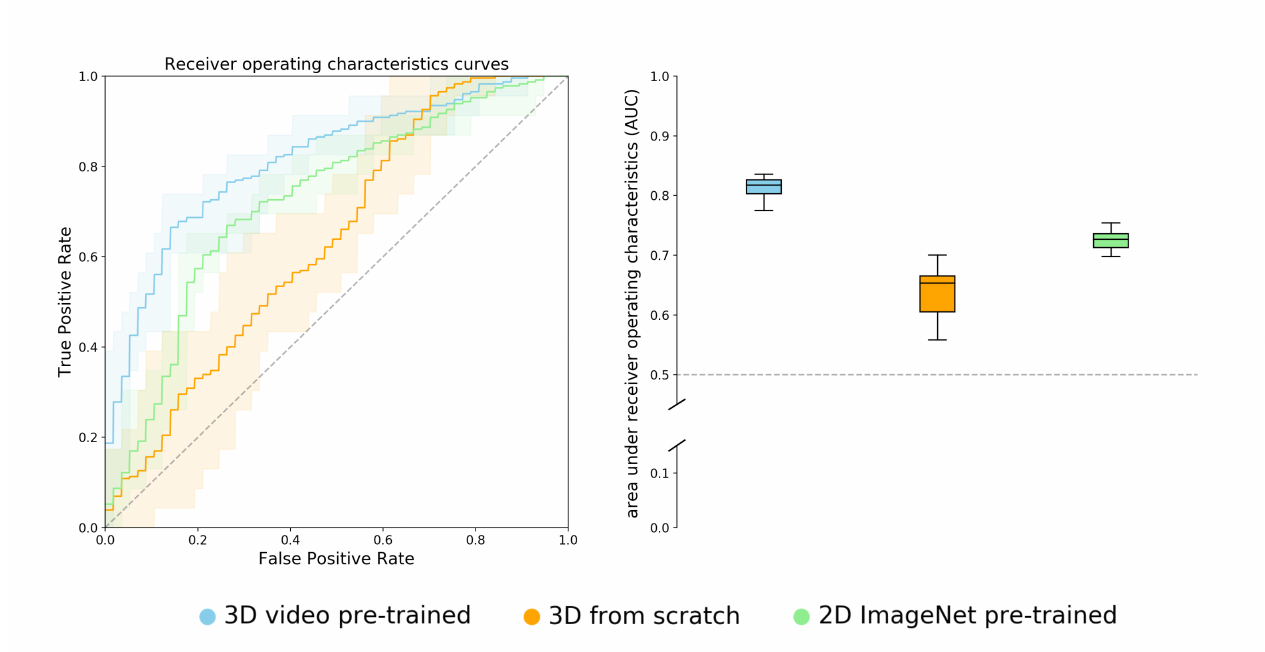
Figure 2. Combined receiver operating characteristics (ROC) plots and AUC score box plots of the test set for the three different models. The ROC plots represent the mean curve of the ten times that models were trained, the shadowed area represents the minimal and maximal curves. Boxes represent lower and upper quartiles, whiskers minimal and maximal values. Median (min, max) AUC score for the video pre-trained model was given by 0.82 (0.77, 0.84). The 3D network trained from scratch and the 2D ImageNet pre-trained model reached an AUC score of 0.65 (0.56, 0.70) and 0.73 (0.70, 0.75),